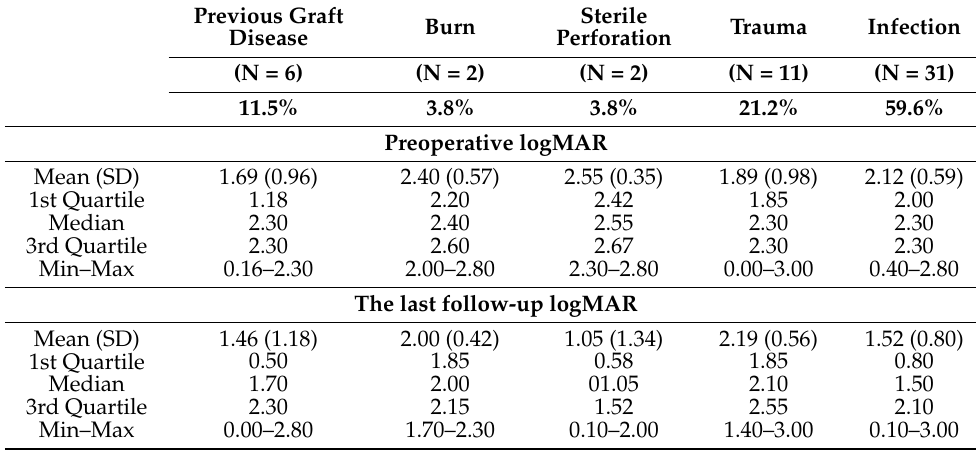
Table 3. Summary of the visual outcomes for each indication for